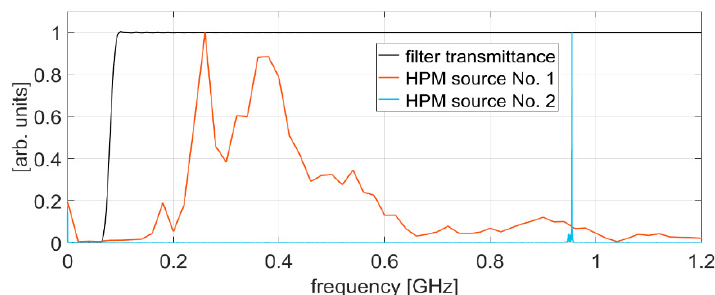
Figure 7. Amplitude characteristics of a finite impulse response (FIR) filter used to reduce parasitic low-frequency components along with the spectra of analyzed signals.